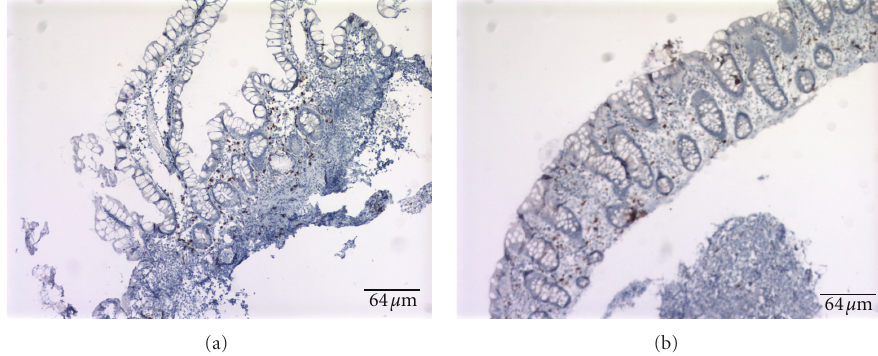
Figure 1: Anti-CD117 staining was used to identify the mast cells. Images of positive CD117 in the small bowel (a) and the colon (b). Positive cells are brown. Abnormal CD117 is considered to be more than 20 cells per high-power field (hpf). Bar length is equal to 64 µ m.